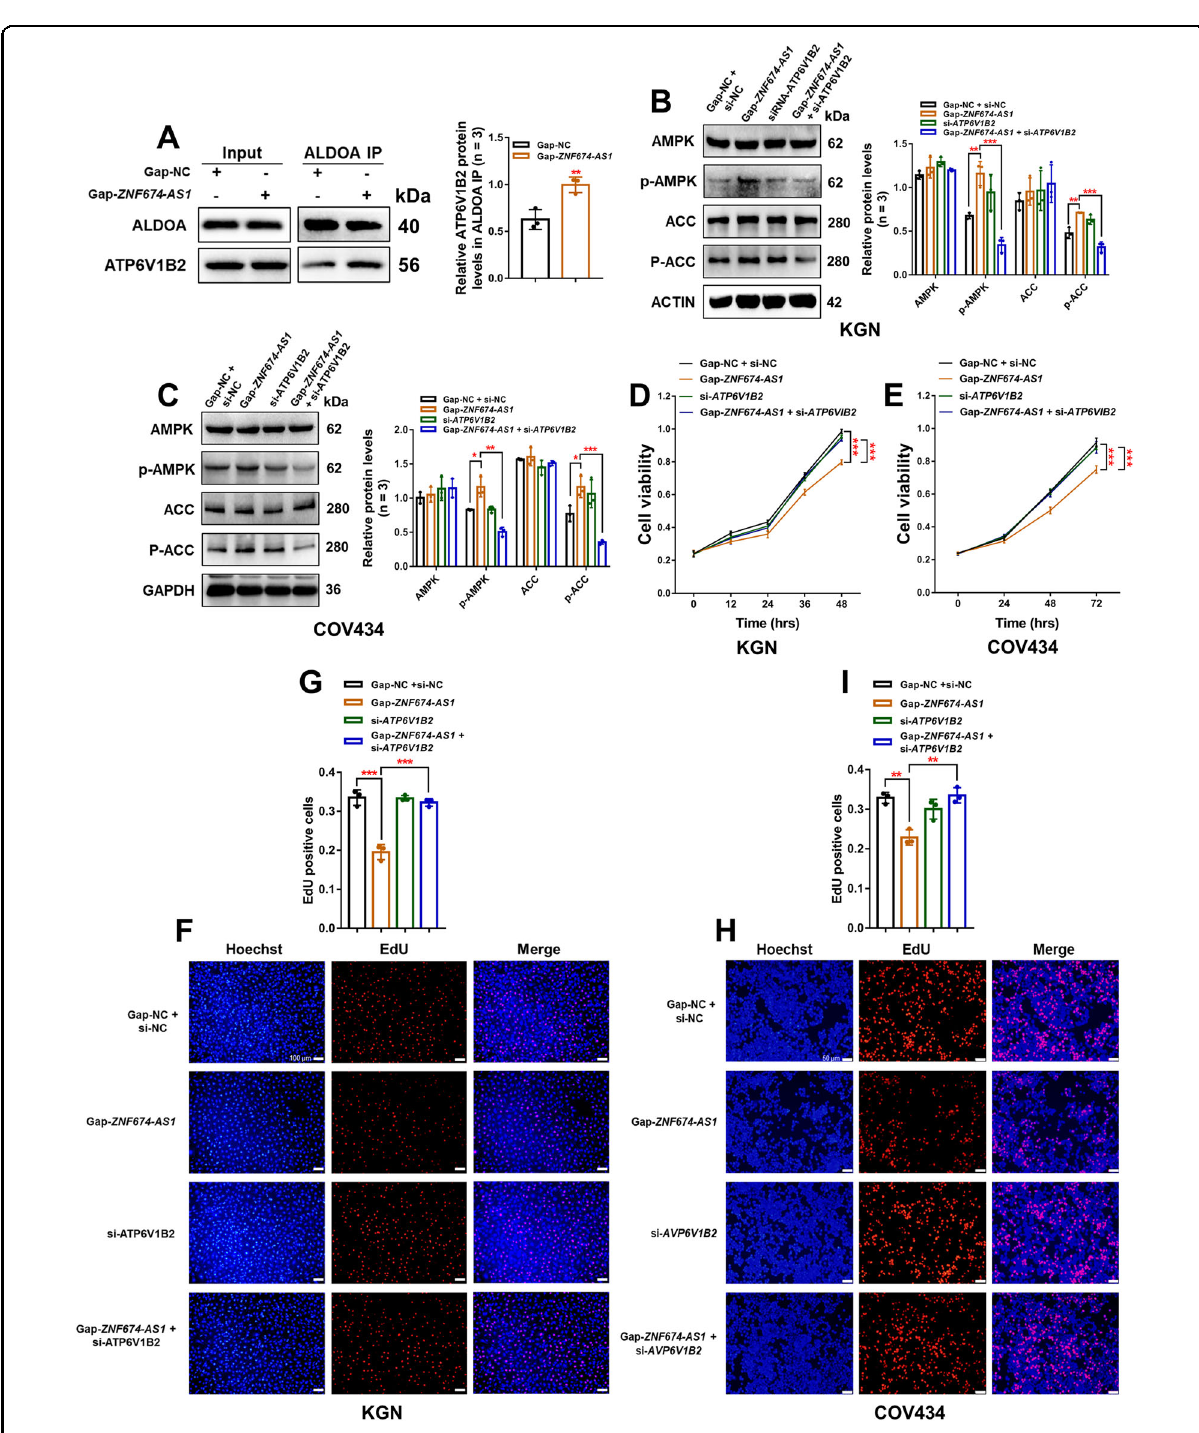
Fig. 6 ZNF674-AS1 regulates the proliferation of GCs through ALDOA/v-ATPase-dependent AMPK activation. A Western blot showing the protein level of ATP6V1B2 immunoprecipitated by anti-ALDOA antibodies in ZNF674-AS1 silenced and negative control KGN cells. For gray value quanti fi cation of ATP6V1B2, data were normalized to ALDOA. Shown are mean±SD. ** p <0.01 by two-tailed Student ’ s t test. B , C Western blot showing the levels of phosphorylated proteins involved in the AMPK signaling pathway in ZNF674-AS1 silenced, ATP6V1B2 silenced, co-silenced and negative control KGN and COV434 cells. For gray value quanti fi cation of proteins, data were normalized to the internal reference. Shown are mean±SD. * p <0.05, ** p <0.01, *** p <0.001 by two-sided Student ’ s t test. D , E The CCK8 assay showed the cell viability of ZNF674-AS1 silencing, ATP6V1B2 silenced, co-silenced and negative control KGN and COV434 cells. Results are expressed as the mean±SD ( n = 3). *** p <0.001 by two-tailed Student ’ s t test. F – I EdU staining assay showing the proliferation ability of ZNF674-AS1 silenced, ATP6V1B2 silenced, co-silenced and negative control KGN and COV434 cells. Results are expressed as the mean±SD ( n = 3). ** p <0.01, *** p <0.001 by two-tailed Student ’ s t test. Scale bars: 100 μ m ( F ) and 50 μ m ( H ). Of fi cial journal of the Cell Death Differentiation